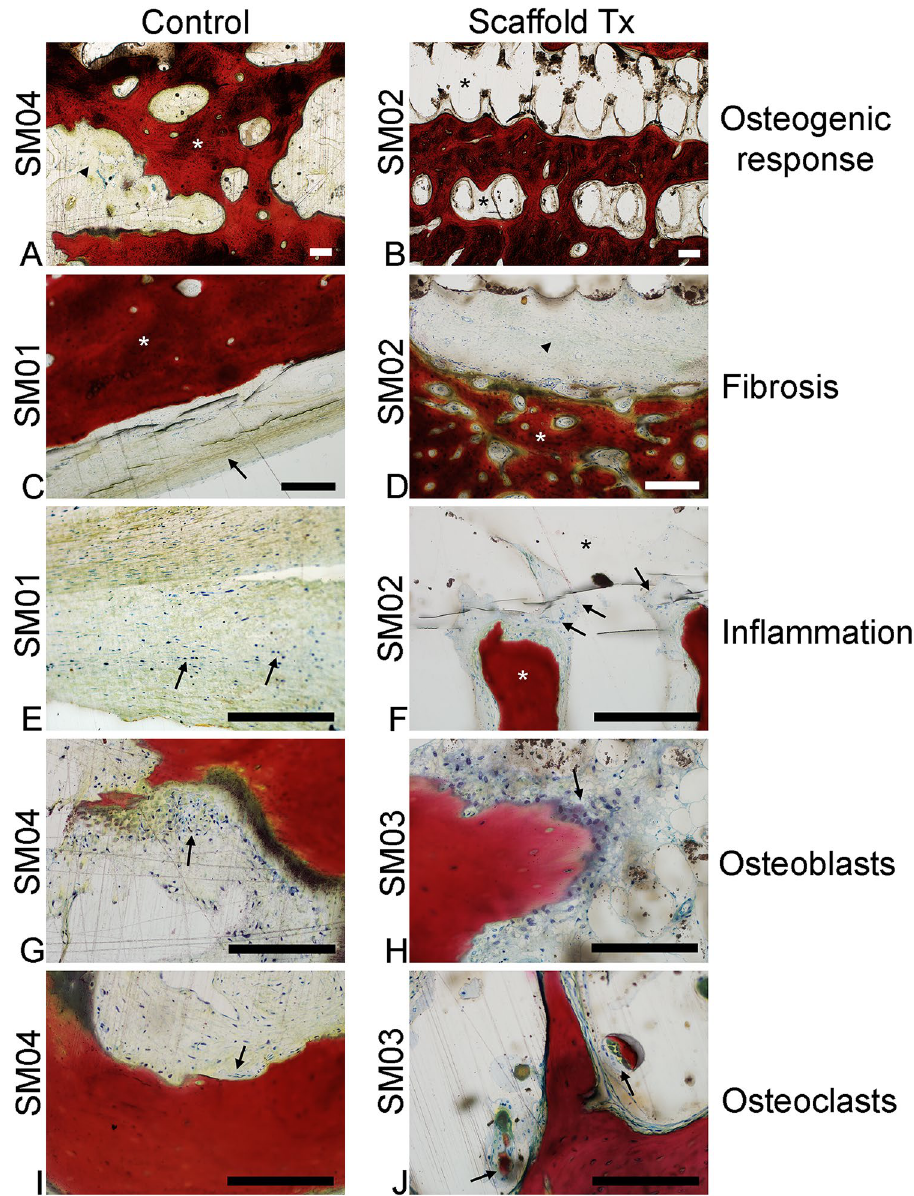
Figure 4. Representative photomicrographs of ISO-10993-6 Histological Scoring Parameters. ( A , B ) Overall osteogenic response (total new bone production) scores of 4 in both a control (SM04) and scaffold-treated animal (SM02). Tissue sections are predominated by anastomosing trabeculae of new bone (white asterisk). Intertrabecular spaces are composed of either fibrosis (arrowhead, A ) or void space left from the implant ( B ). ×4 magnification. ( C , D ) Images demonstrating fibrosis scores of 1 in both a control (SM01) and scaffold-treated animal (SM02). Thin bands of dense fibrous connective tissue (arrow in C , arrowhead in D ) are juxtaposed between new bone and defect or implant void spaces. ×10 magnification. ( E , F ) Image demonstrating cumulative inflammation scores of 2 in a control animal (SM01) and 5 in a scaffold-treated animal (SM02). Inflammation in control animals ( E ) was characterized by few scattered lymphocytes and plasma cells (arrows) within the fibrous tissue, while scaffold-treated animals ( F ) were characterized by infiltrates of macrophages and multi-nucleate giant cells (arrows) present in the fibrous tissue between new bone (white asterisk) and the implant void space (black asterisk). ×20 magnification. ( G , H ) Osteoblast activity scores of 2 in a control animal (SM04) and 1 in a scaffold-treated animal (SM03). Few clusters of plump osteoblasts (arrows) segmentally line endosteal surfaces of new bone. ×20 magnification. ( I , J ) Osteoclast activity scores of 1 in both a control (SM04) and scaffold- treated animal (SM03). Rare osteoclasts (arrows) were observed along endosteal surfaces of new bone. ×20 magnification. All scale bars indicate 200 μm. Images were captured with an Olympus BX51 microscope